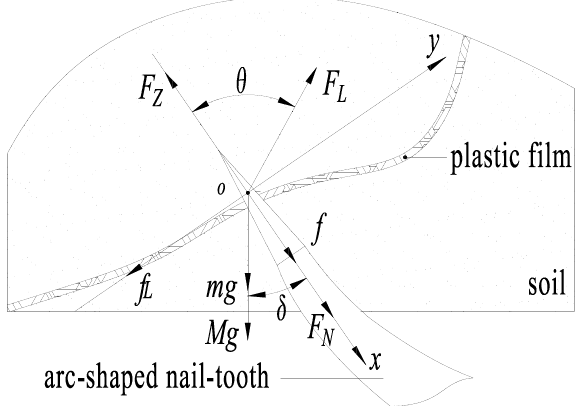
Figure 3. Schematic diagram of residual film force analysis during film-picking operation. According to the empirical formula [14], the work used by the tooth roller device to rotate once